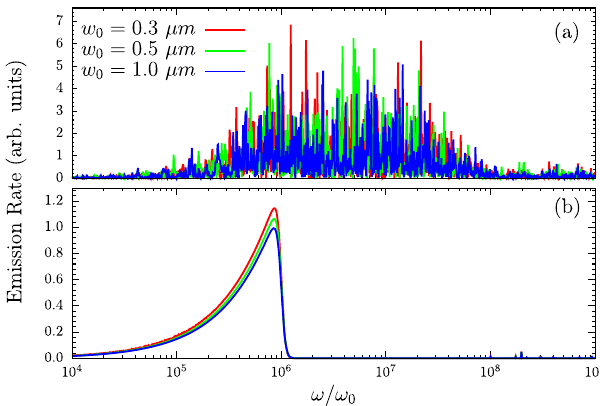
FIG. 17. Thomson emission spectra calculated in the back- π , for the electrons in Fig. 15. Panel scattering direction, θ obs ¼ (a) shows the spectra for the exact setup described in Fig. 15, while panel (b) shows the spectra calculated using a circularly polarized laser pulse with the same peak intensity and